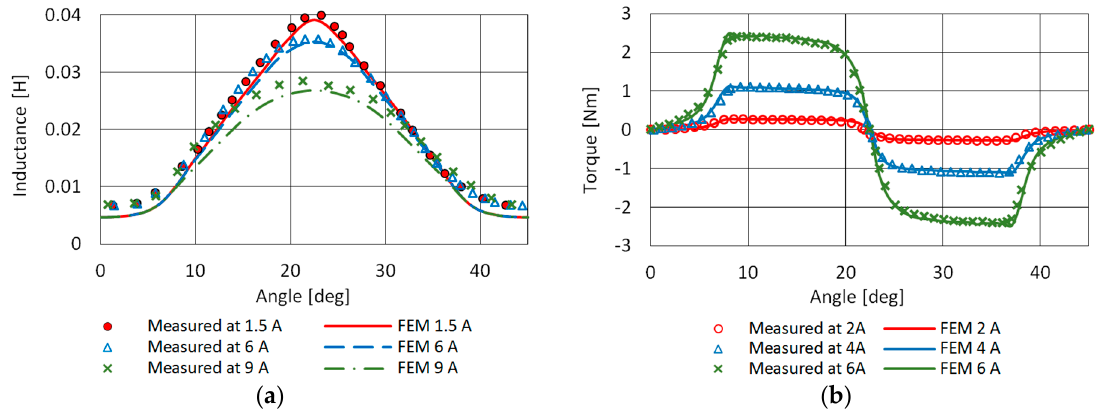
Figure 6. ( a ) Comparison of measured and calculated inductance profiles; ( b ) measured and calculated torque profile.